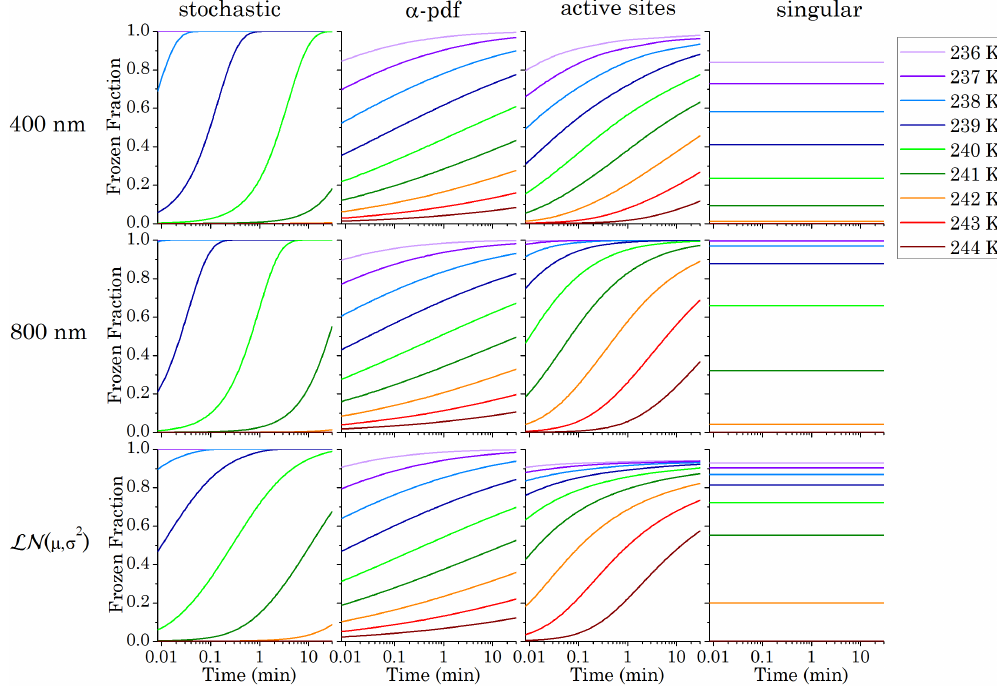
Fig. 8. Calculated increase in the frozen fraction with time for 400nm, 800nm monodisperse particles and for a particle ensemble exhibiting a log-normal size distribution with µ = 600nm and σ 2 = 1. The fitting parameters obtained in Sect. 4.1 for the four different models are applied to calculate a 30min time evolution of the frozen fraction at temperatures between 236K to